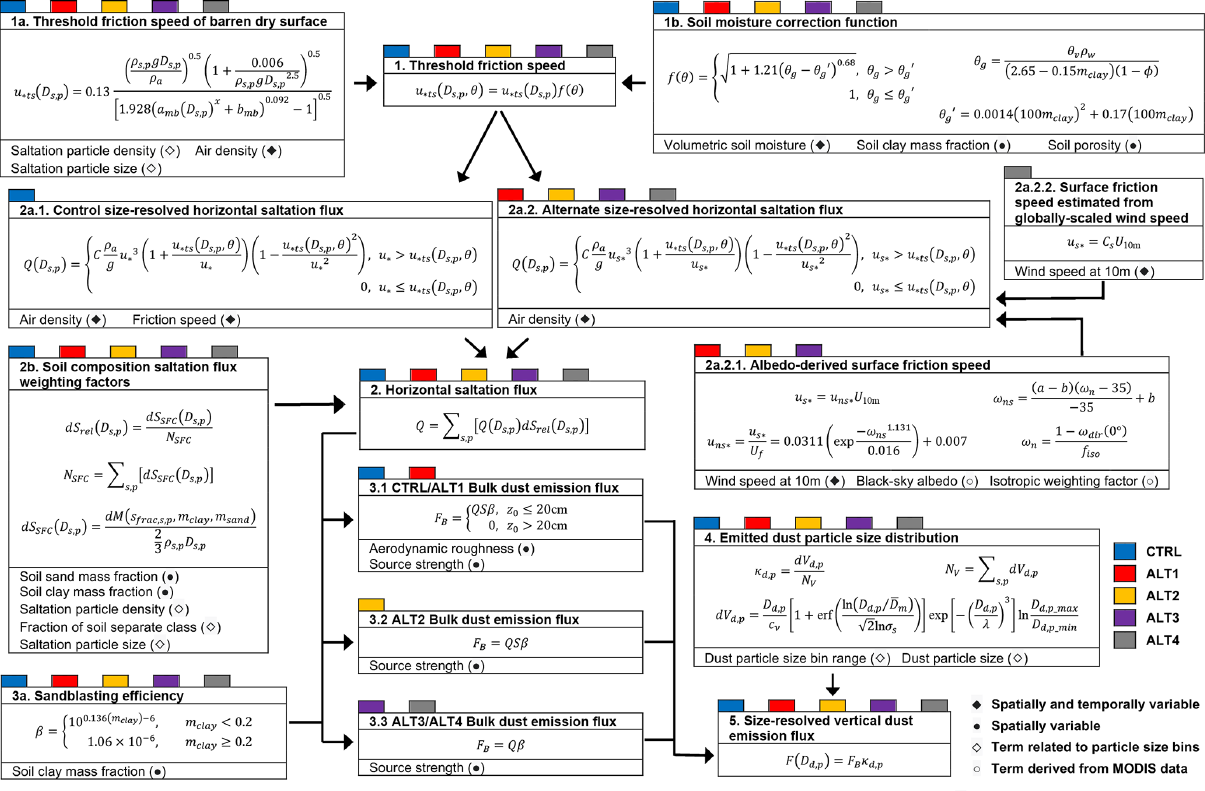
Figure 6. Schematic of the original and modified components of the dust emission module and their required inputs. A black diamond indicates that the parameter varies spatially and temporally. A black circle indicates that the parameter varies spatially but not temporarily, and a hollow diamond means the term is related to a particle size bin attribute table. The hollow circle indicates that the field is derived from MODIS data. These input parameters are provided to the AFWA dust emission module by the WRF-Chem model. Color boxes imply which module components are used in the five different test configurations. See the comprehensive variable list in Table A1 for variable